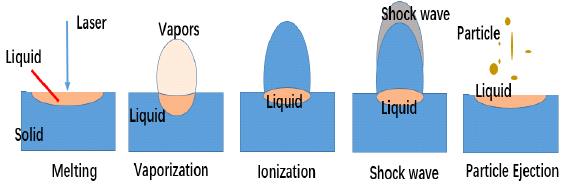
Figure 1. Schematic diagram of the thermal mechanism of laser initiation.